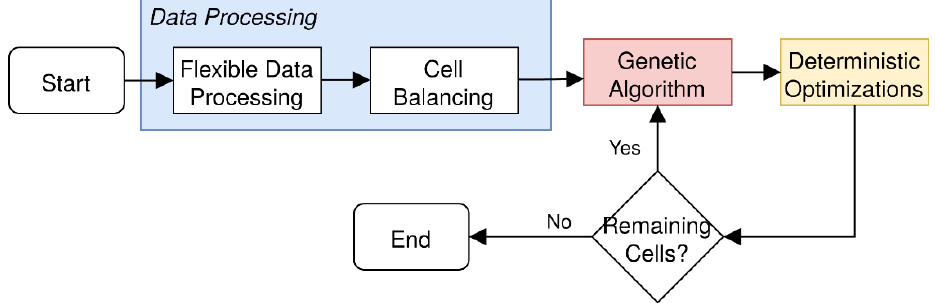
Figure 6. Flowchart for flexibility usage.